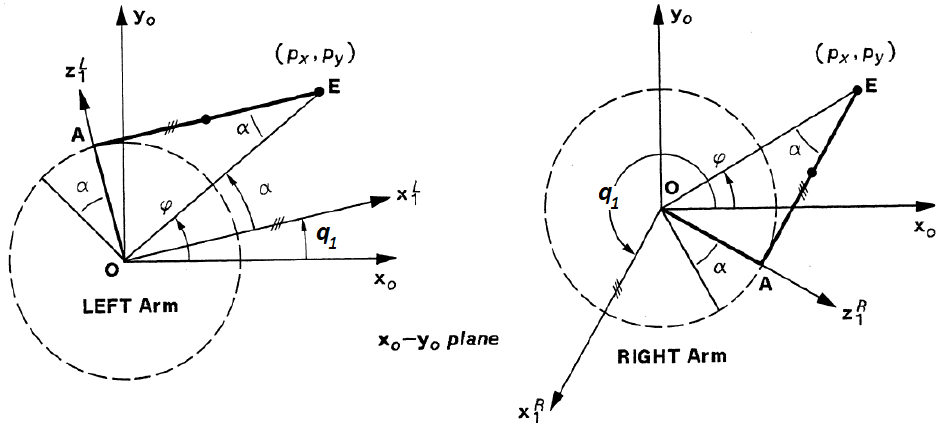
Figure 4. Geometric solution for joint 1 ( q 1 ), showing both possible configurations: “LEFT Arm” ( left ) and “RIGHT Arm” ( right )